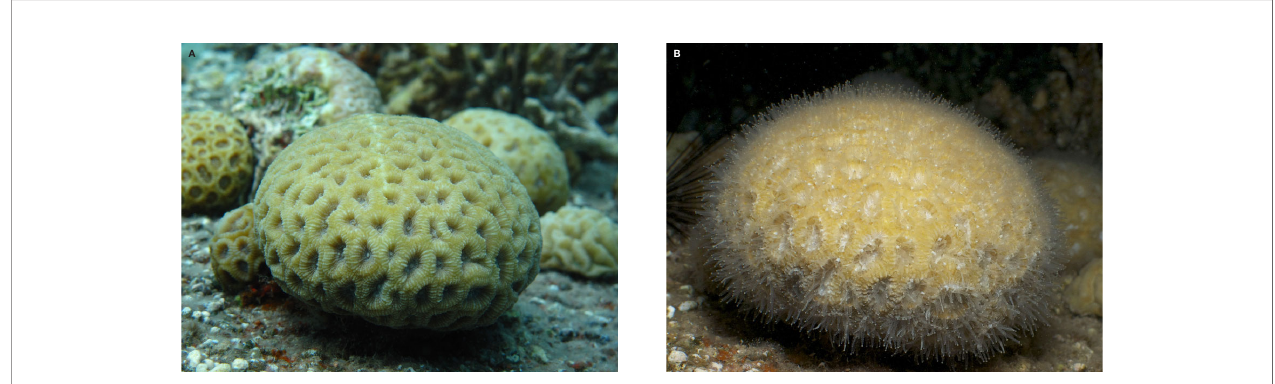
FIGURE 1 | Pictures of the D . favus coral during the day when its tentacles are contracted (A) and during the night when the tentacles are extended (B)